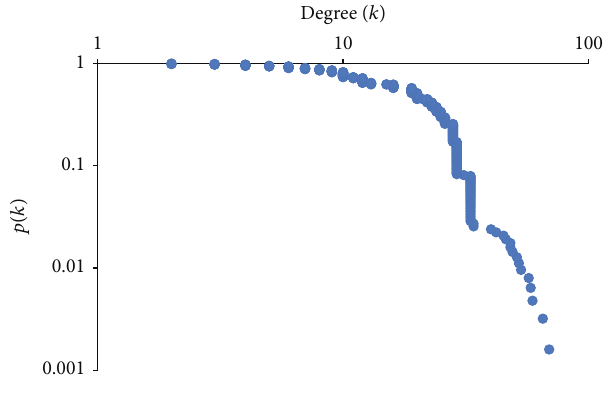
Figure 2: Cumulative degree distribution.